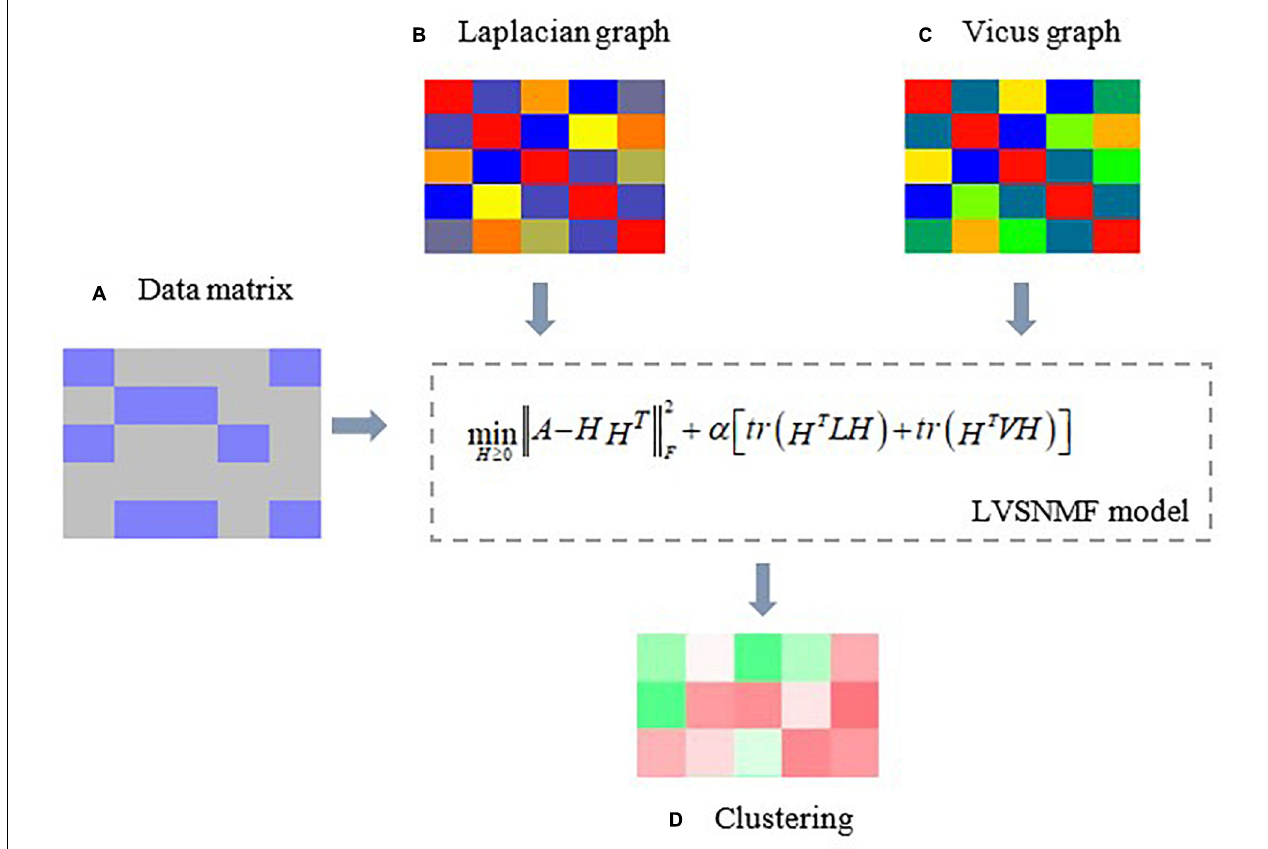
FIGURE 1 | An illustrative example of the proposed LVSNMF algorithm. (A) the original data matrix (gene expression matrix, microbiome abundance profile matrix, and so on. (B) Laplacian graph used to maintain manifold consistence assumptions. (C) A Vicus graph explores the local geometrical structure in the data. Then c and d are introduced into the proposed LVSNMF model, which integrated the global (Laplacian) and local (Vicus) geometrical structure of the original data. (D) the clustering result given by